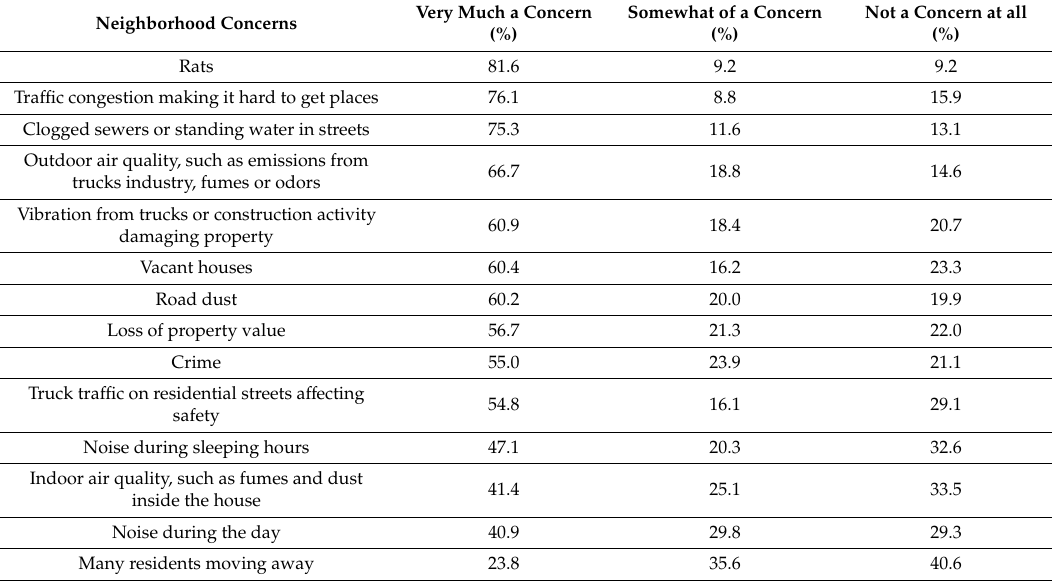
Table 5. Neighborhood concerns reported by survey respondents, 2018 ( n = 146, weighted